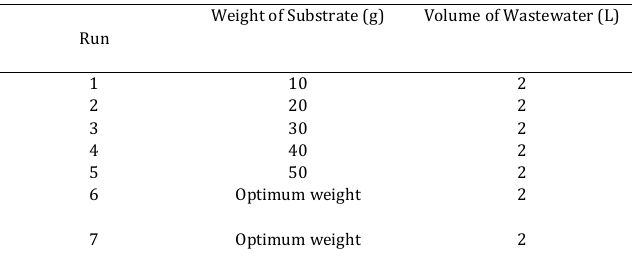
Table 1: Experimental Design Matrix for Orange and Pineapple Peel Weight of Substrate (g) Volume of Wastewater (L) Run